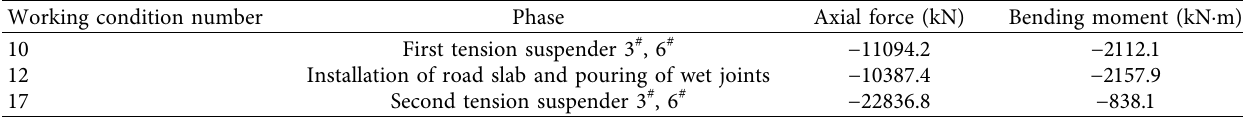
Table 2: Loads under various working